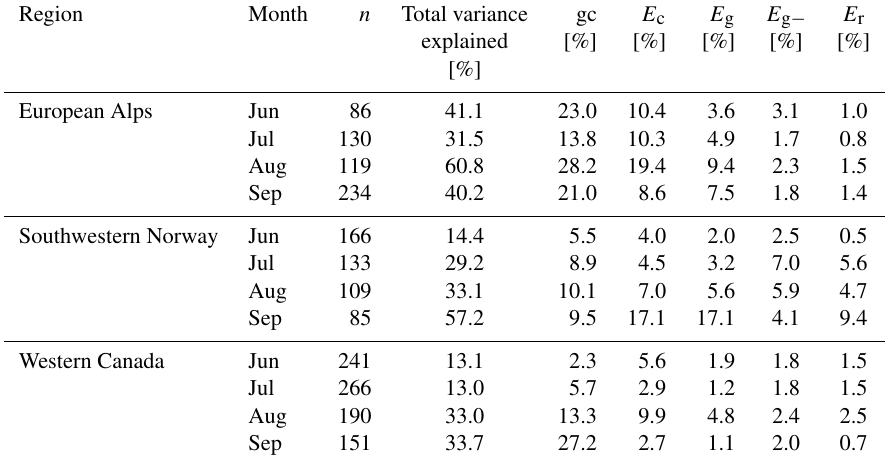
Table 5. Variance in C explained by catchment characteristics in a linear regression model; n indicates the number of WD events that were used for the